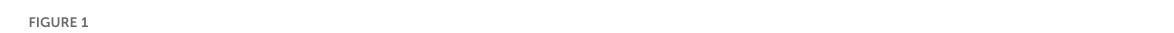
FIGURE1 Cre recombination mediates excision of the loxP site-flanked exon 1 of Nck2 . (C) Experimental groups consisted of male and female mice with (eNck2 + ) and without (eNck2-) NCK2 expression in the endothelium (left). Western blots using extracts from lung endothelial cells showing tamoxifen-induced deletion of NCK2 alongside levels of the endothelial marker CD144 (VE-cadherin) and the loading control β -ACTIN (right). (D) Diagram showing timeline (starting on week 8 after birth) of experimental manipulations, including tamoxifen injections (arrowheads), duration of high fat diet (HFD) regime, timing of tissue collection (arrows), and key readouts. (E) Representative images of en face preparations of mouse thoracic aortas stained with Oil Red O. Aortas were obtained from male (left) and female (right) mice fed HFD for 8 or 16 weeks to assess atherosclerosis initiation and progression, respectively. The scale bar represents 2mm. (F) Box plots showing quantification of plaque burden as percentage of exposed intimal area occupied by lesions in male (left) and female (right) mice. Statistical significance was determined by two-way ANOVA followed by Tukey’s multiple means comparison test. * p < 0.05. Numbers of animals/group (n) are indicated in parentheses.